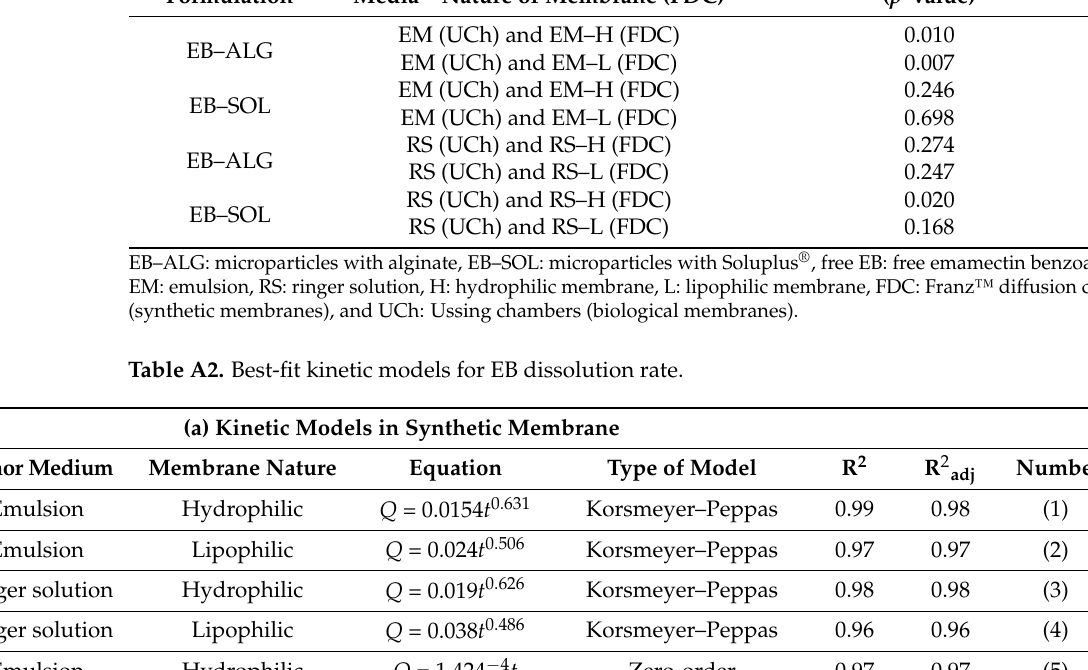
Table A2. Best-fit kinetic models for EB dissolution rate.